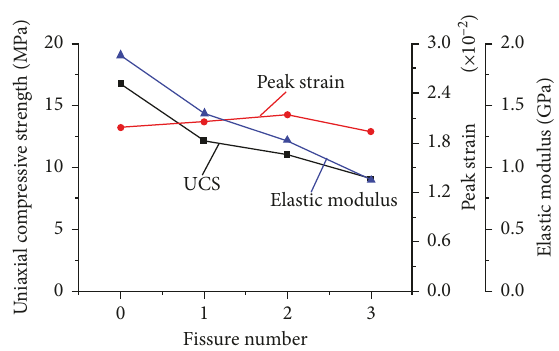
Figure 5: Influence of fissure number on the mechanical parameters of layer-crack